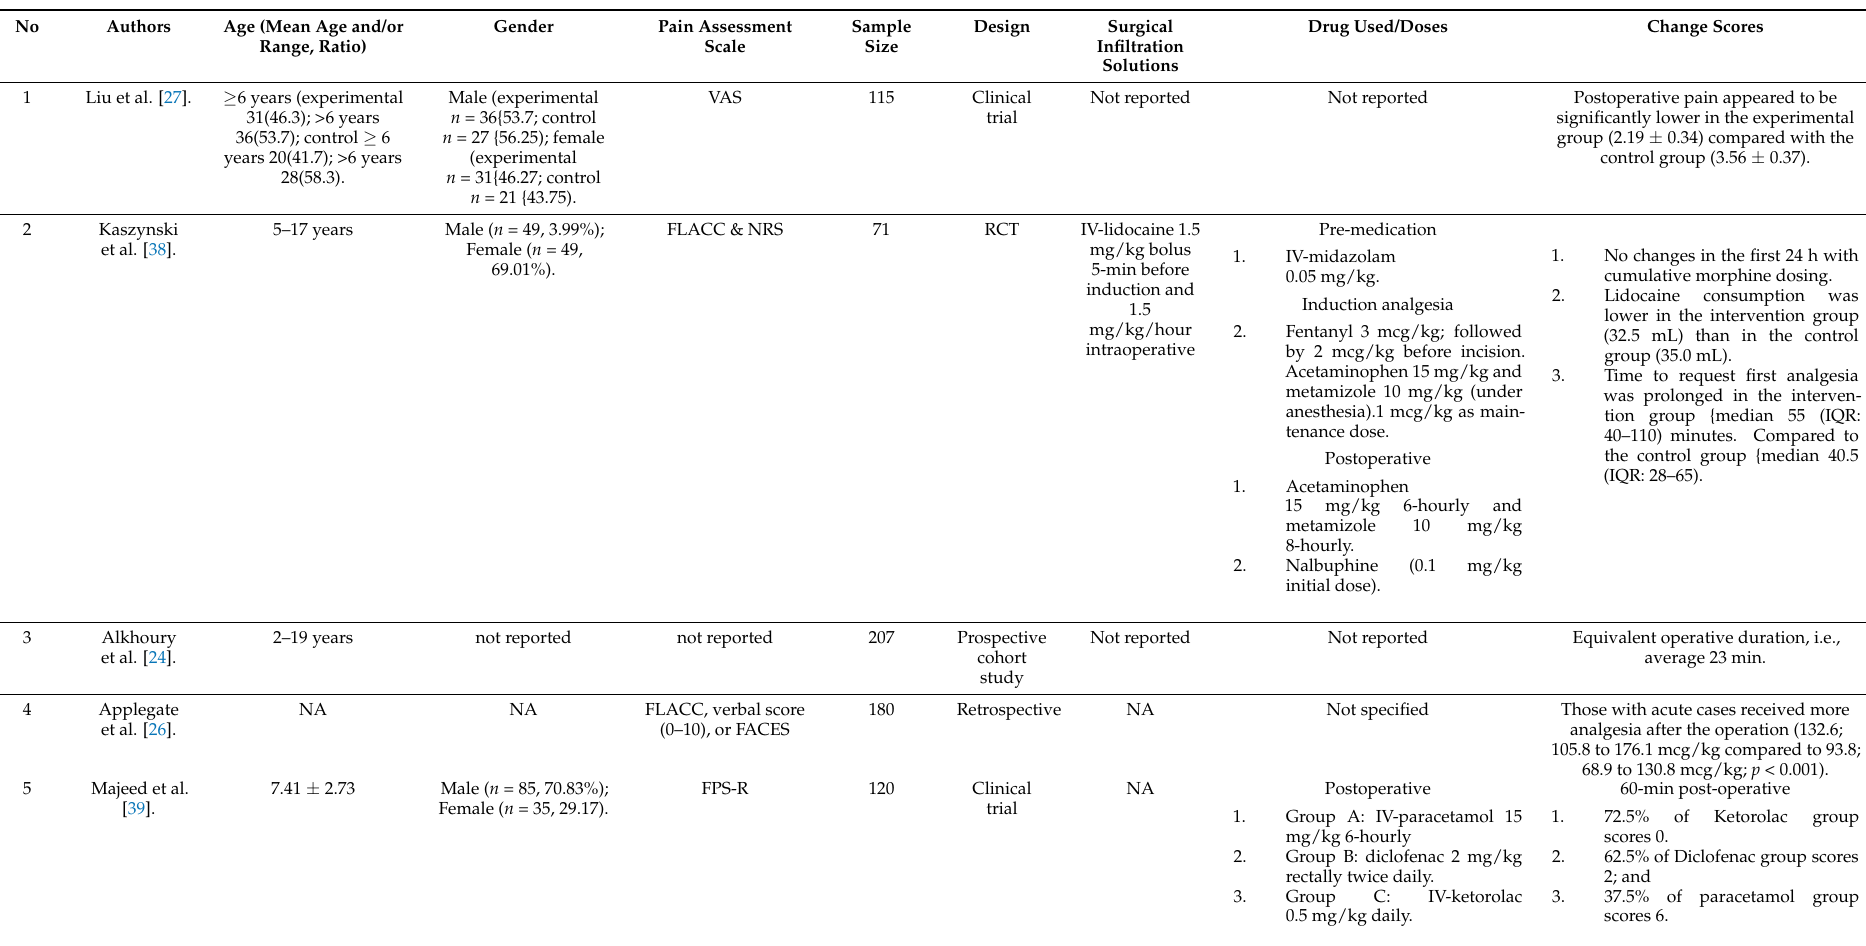
Table 1. Characteristics of the included